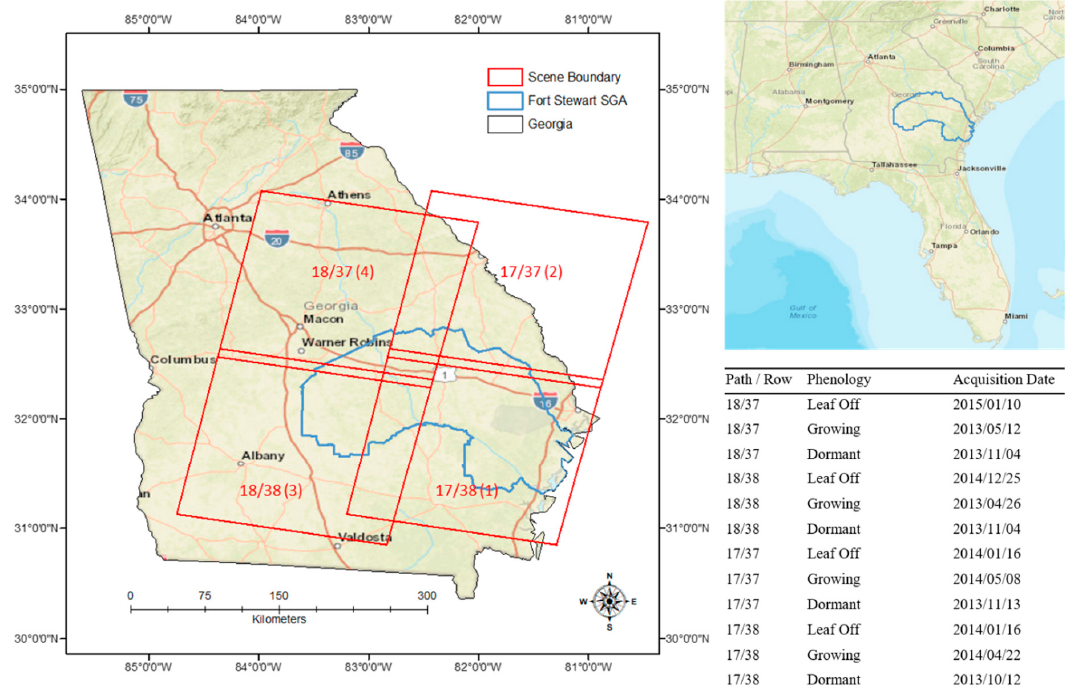
Figure 1. Location, dates, path/row and mosaicking order of Landsat 8 imagery used in the study. Path/row 17/38 was used as the reference scene to relatively normalize scenes within a given phenology. The order in which images for a given phenology were mosaicked together is displayed in parentheses after path/row within the left most image.